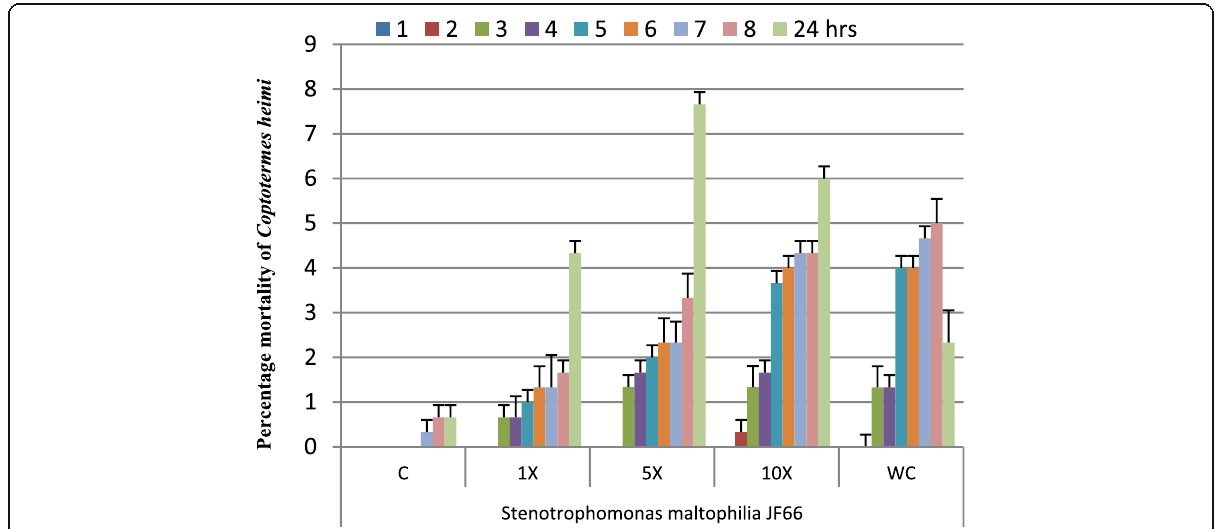
Fig. 9 Percentage mortality of Coptotermes heimi exposed to the cultures (WC) and cell-free culture fluids of varying strength of S . maltophilia